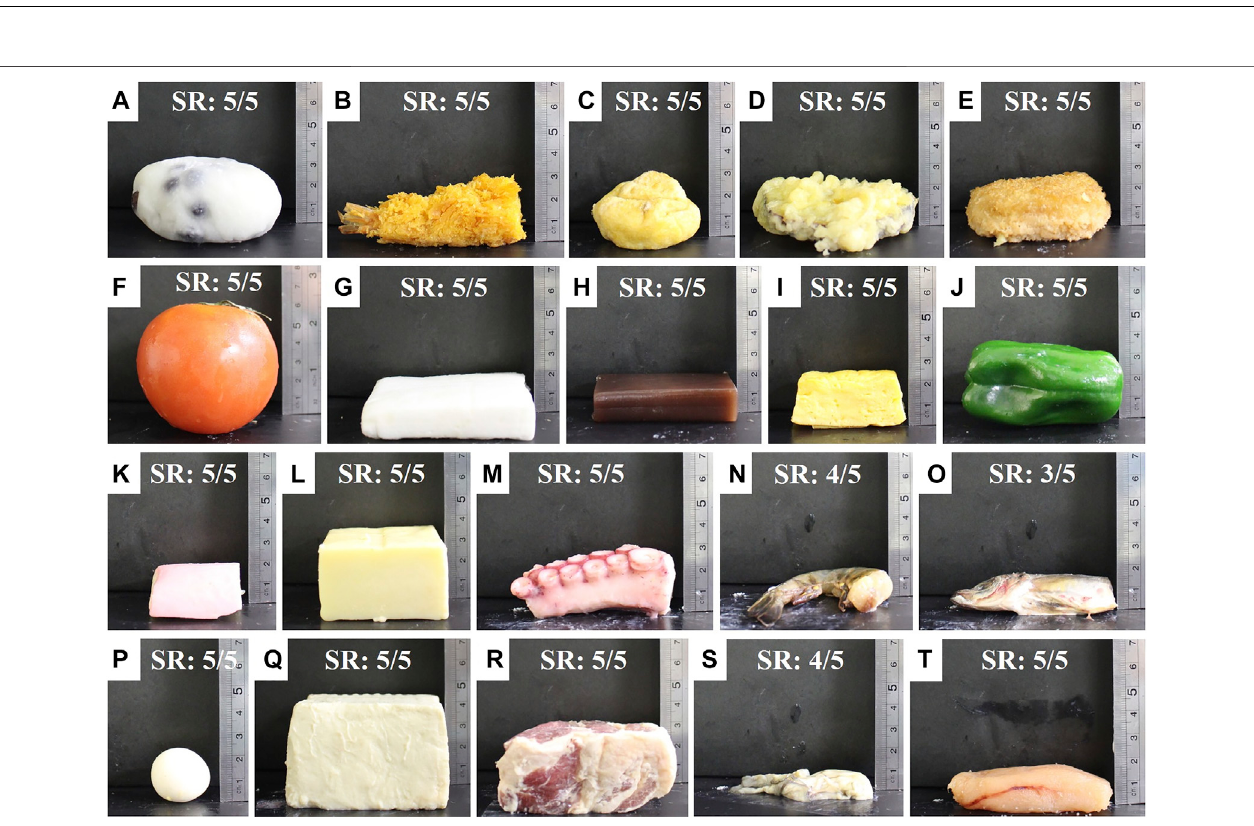
FIGURE 9 | Food items used in the grasping experiments: daifuku (small round mochi stuffed with sweet red bean paste) (A) , fried shrimp (B) , ganmodoki (deep- friedtofudumpling) (C) ,sweetpotatotempura (D) ,croquette (E) ,tomato (F) ,boiled fl at fi shcake (G) ,sweet beanjelly (H) ,rolledomelet (I) ,greenpepper (J) ,kamaboko (steamed fi sh cake) (K) , cheese (L) , octopus leg (M) , raw shrimp (N) , raw carangidae fi sh (O) , quail egg (P) , tofu (Q) , meat (R) , raw oyster (S) , and Pollock roe (T) . “ SR ” indicates the success rate of the handling tests.